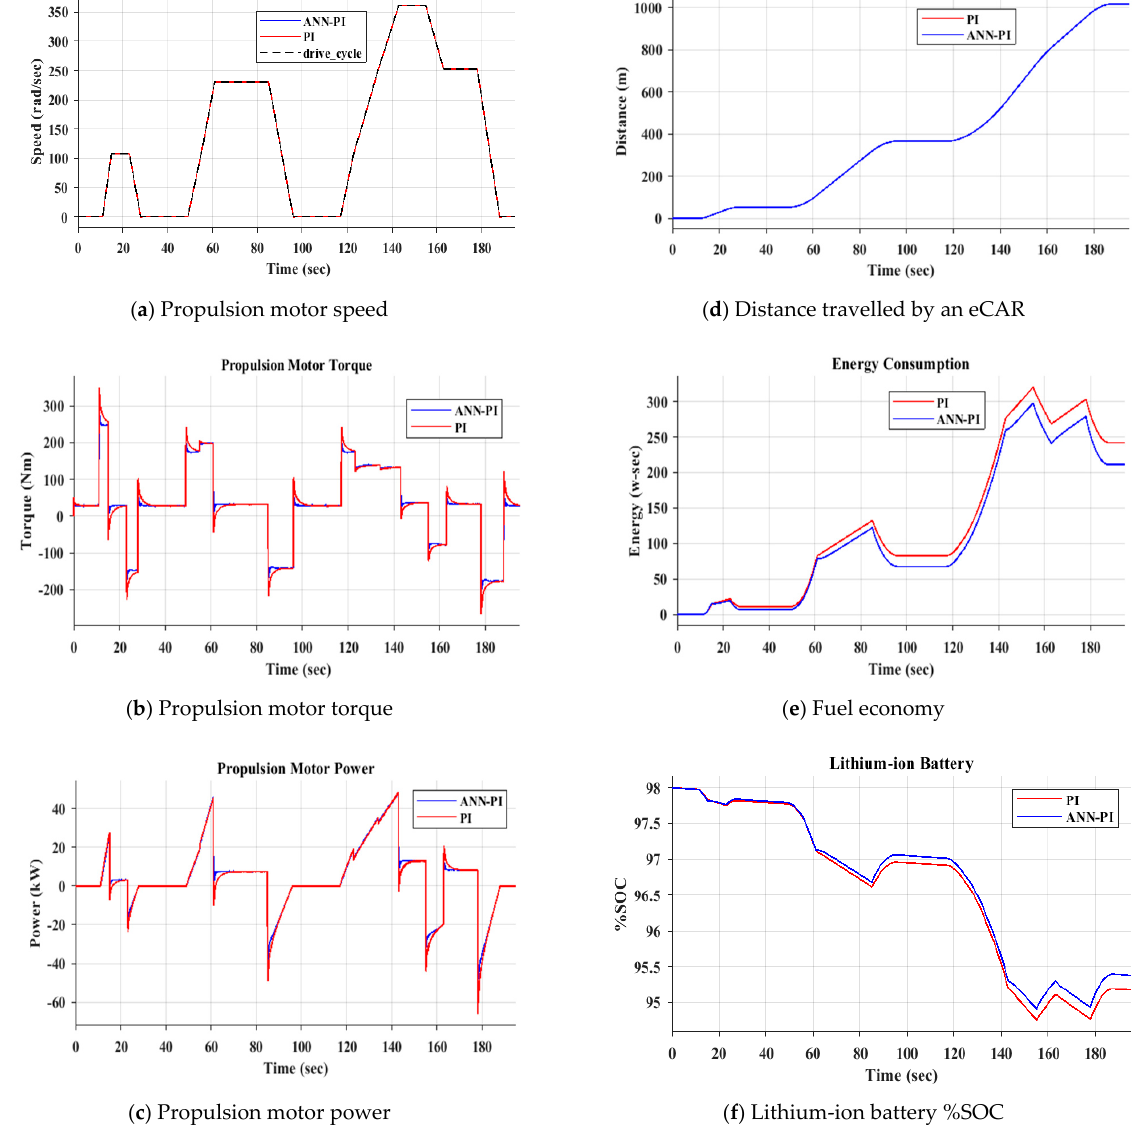
Figure 17. The performance of an eCAR with a conventional torque controller and an ANN tuned PI controller under an ECE (R15) cycle.